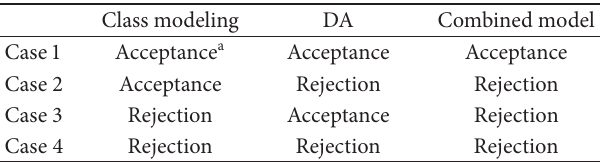
Table 1: Fusion of discrimination analysis (DA) and class modeling for discrimination of PDO/non-PDO